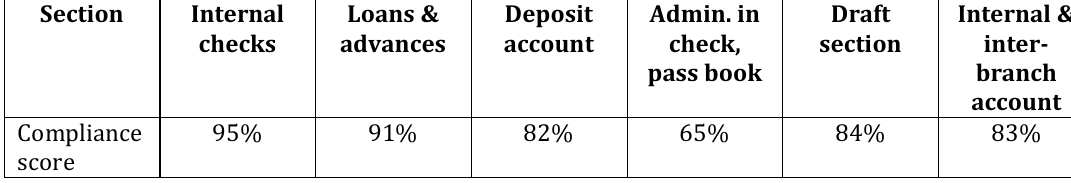
Table 4: Average Compliance Scores of Various Heads of Bank Managers